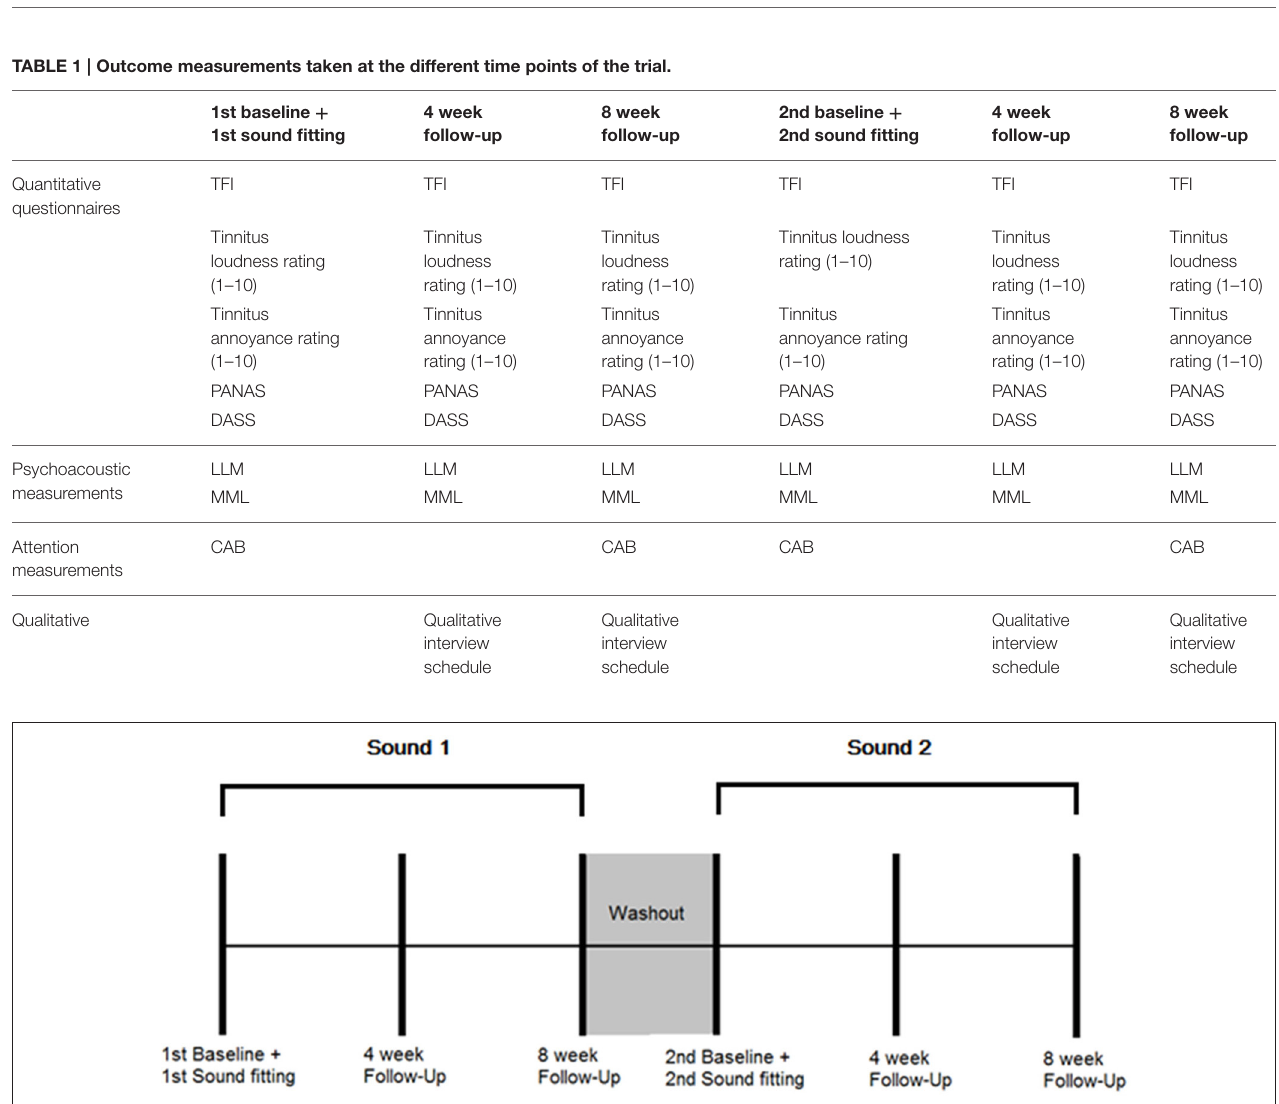
FIGURE 1 | Protocol for data collection. Multiple outcome measurements were taken at the following time points: 1st sound fitting (Baseline), and 4 and 8 weeks after first fitting while the sound was being used. A washout period of 3 weeks followed in which no sound was administered. Multiple outcome measurements